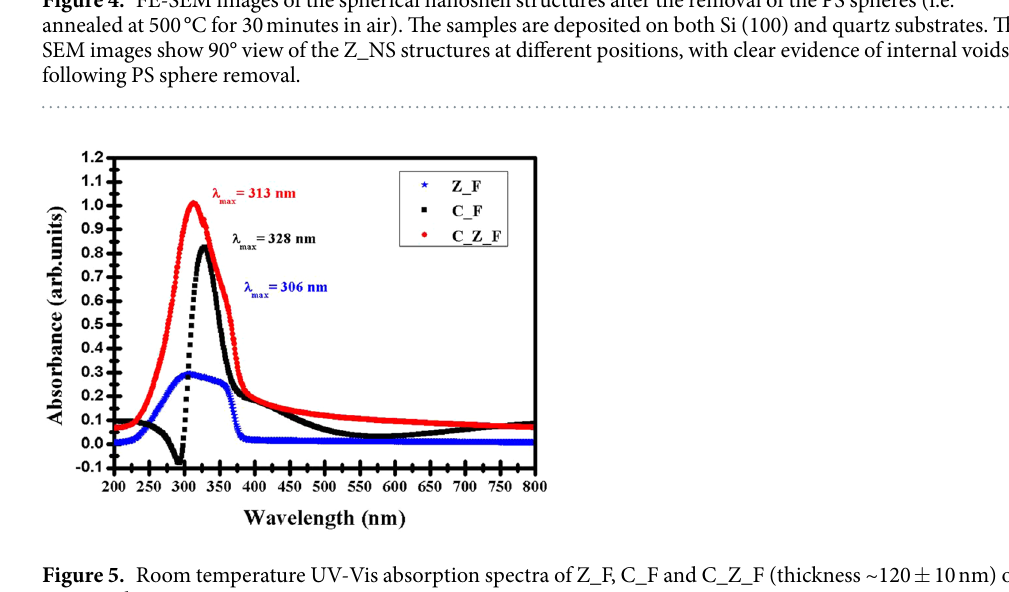
Figure 5. Room temperature UV-Vis absorption spectra of Z_F, C_F and C_Z_F (thickness ~120 ± 10 nm) on quartz